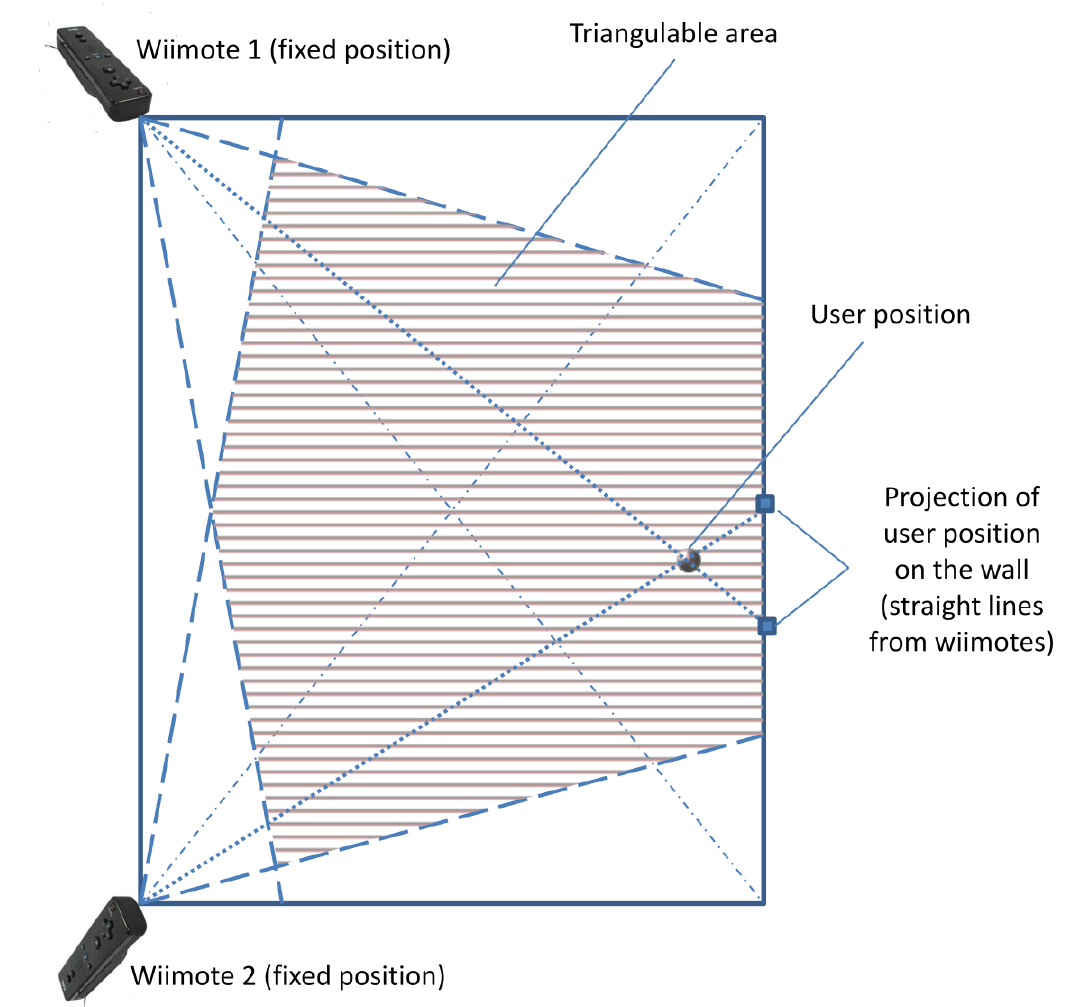
Figure 8. Elements participating in the triangulation